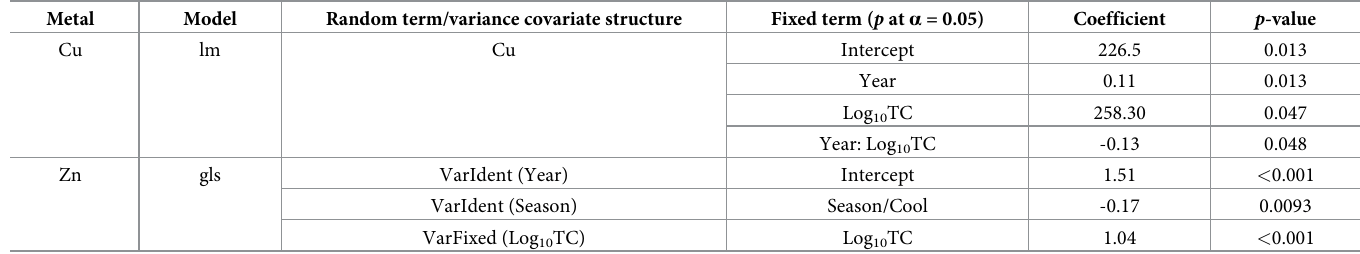
Table 2. Model parameters for Cu and Zn. Metal Model Random term/variance covariate